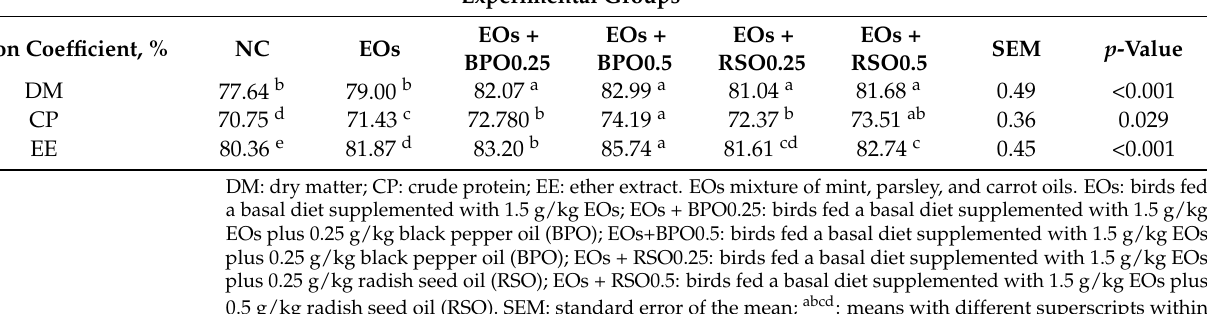
Table 4. Effect of EOs with black pepper oil or radish seeds oil on nutrient digestibility. Experimental